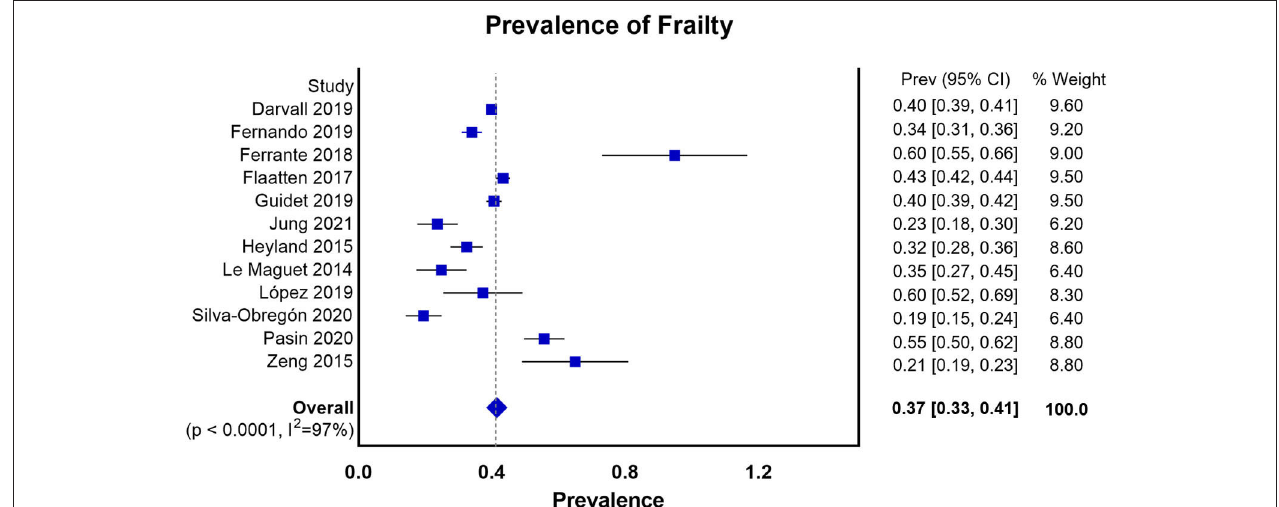
FIGURE 2 | Prevalence of frailty in the elderly patients admitted to ICU according to all the measures of